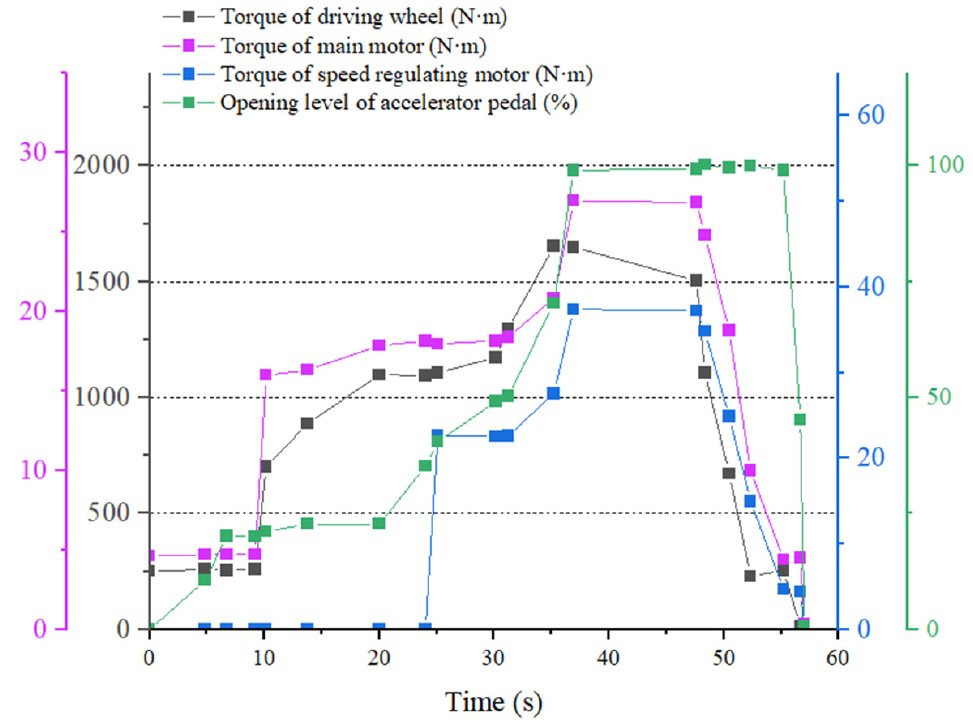
Figure 18. Curves of drive wheel equivalent torque, PTO load torque, main motor torque, speed control motor torque, and accelerator pedal opening.